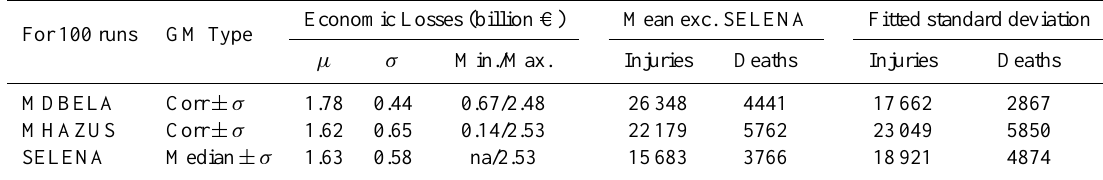
Table 6. Economic and social losses for daytime scenarios (population=353657) for median and correlated ground motions for 3 different ELE software packages. Economic Losses (billion C) Mean exc. SELENA Fitted standard deviation For 100 runs GM Type µ σ Min./Max. Injuries Deaths Injuries Deaths MDBELA Corr ±